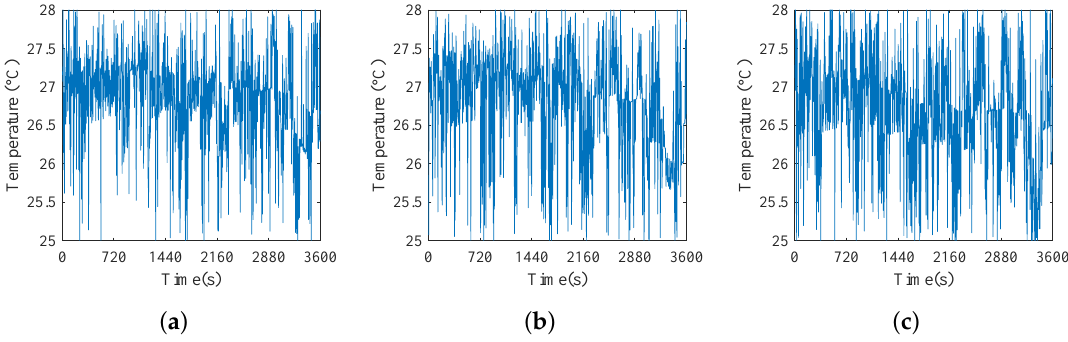
Figure 8. Setpoint temperature change in Scheme A, Scheme B, and Scheme C when N = 800. ( a ) Setpoint temperature change in Scheme A when N = 800. ( b ) Setpoint temperature change in Scheme B when N = 800. ( c ) Setpoint temperature change in Scheme C when N =